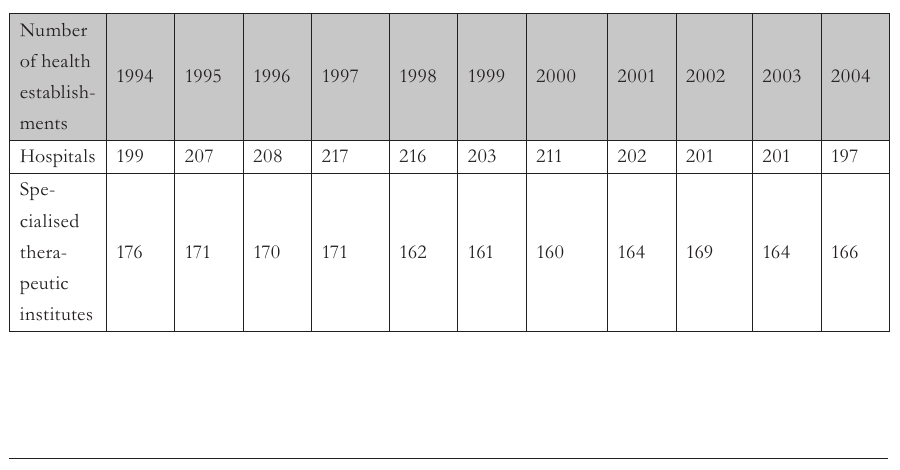
Tab. 1 – The number of health establishments in the Czech Republic (Source: The Institute of Health Information and Statistics of the CR,